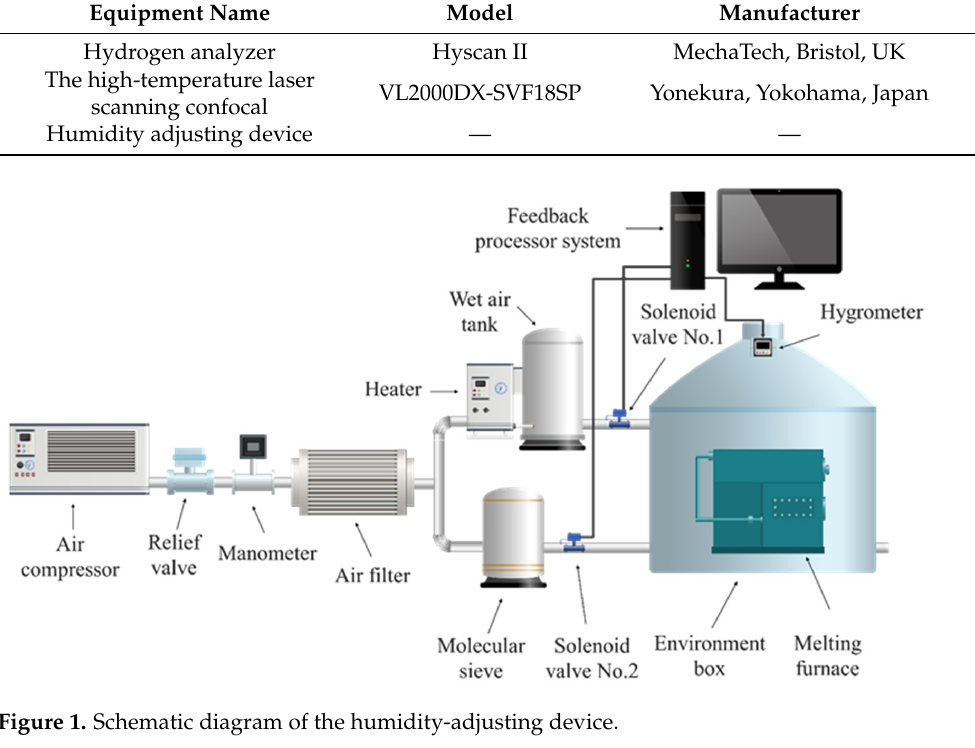
Figure 1. Schematic diagram of the humidity-adjusting device.